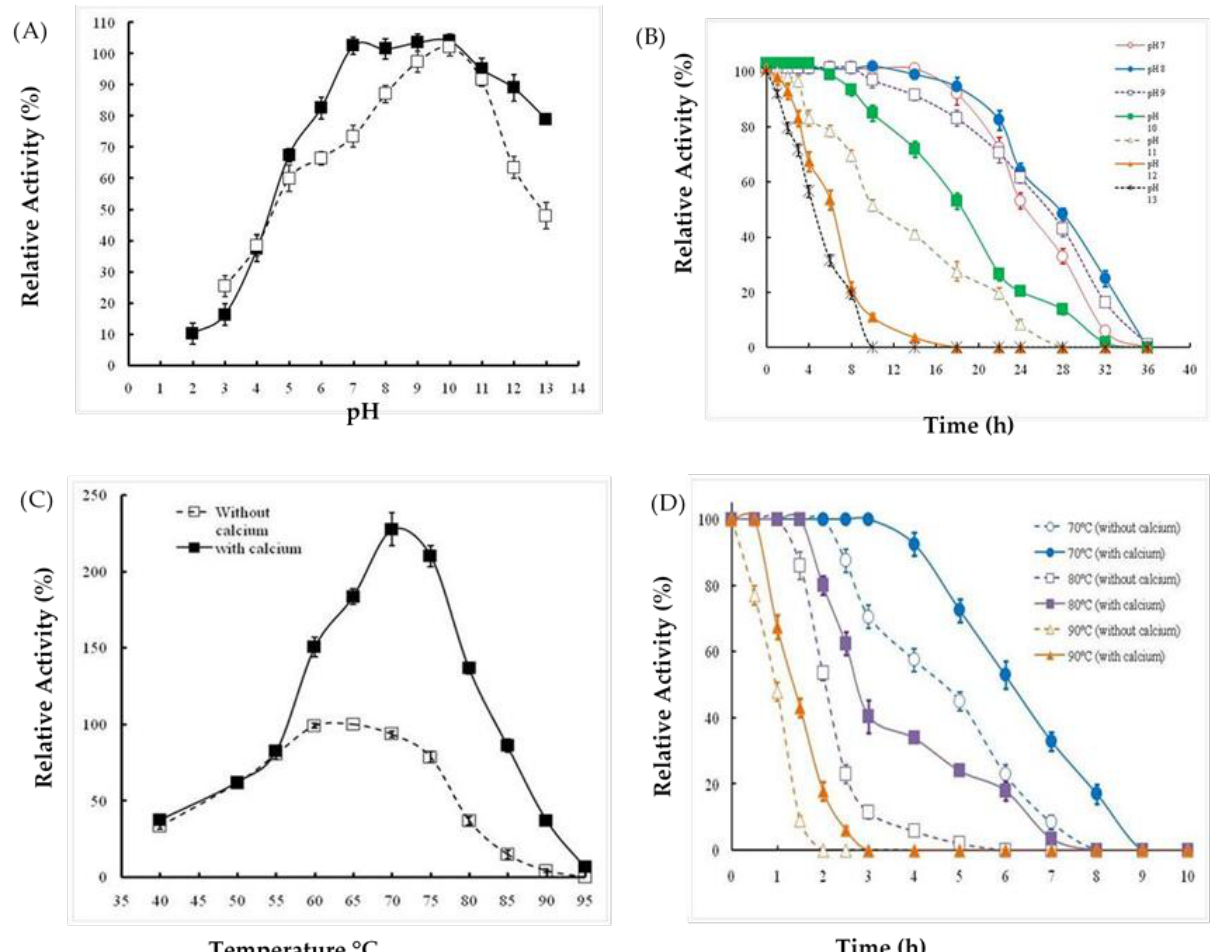
Figure 6. Evaluation of pH effect on the activity (white squares) and stability (black squares) of Ba.St.Pr. ( A ). Effect of alkali pH on Ba.St.Pr stability at various incubation times from 0 to 36 h ( B ). Evaluation of the effect of temperature on protease activity without Ca 2+ ions (white squares) and with Ca 2+ ions (black squares) of Ba.St.Pr. ( C ). Effect of extreme temperatures on Ba.St.Pr stability at various incubation times from 0 to 10 h ( D ).